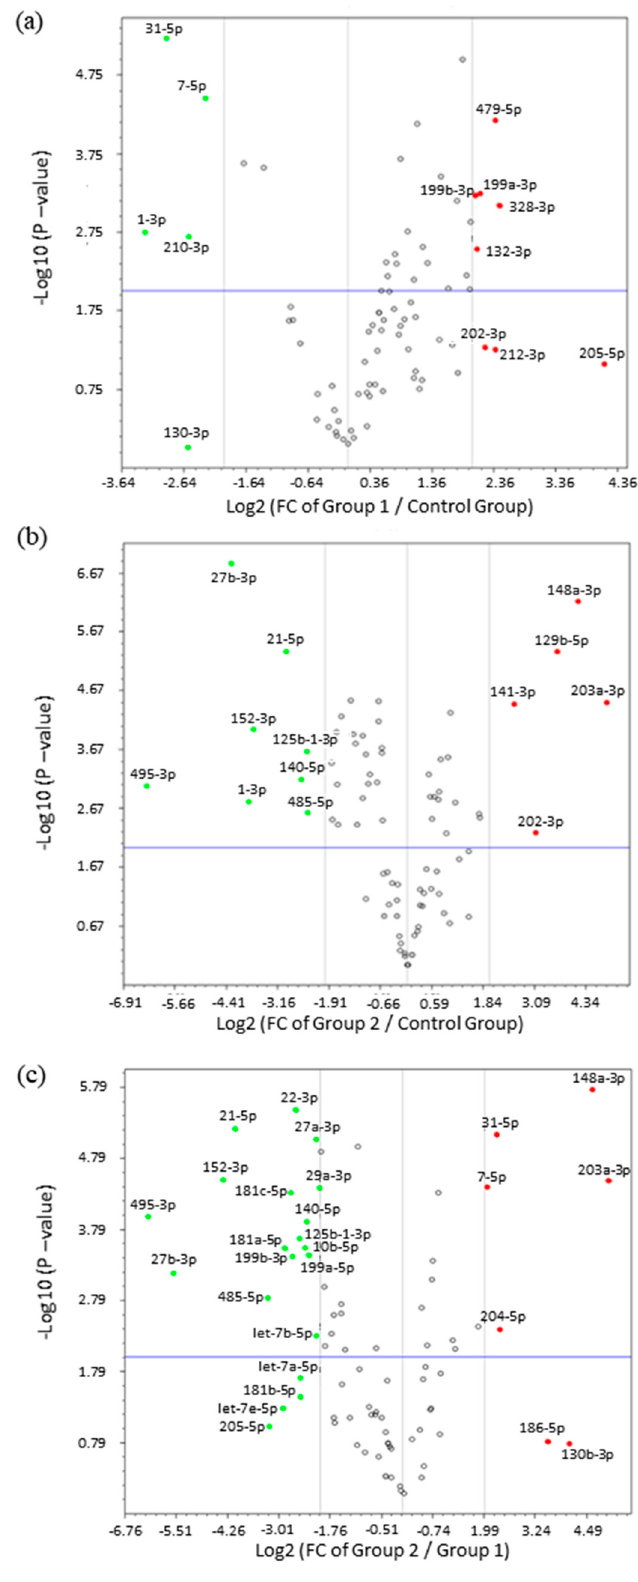
Figure 3. Volcano plots with differentiated expression of miRNAs. ( a ) miRNAs expression in ULM (group 1) compared with MM (control group); ( b ) miRNA expression in ULMS (group 2) compared with MM; ( c ) miRNAs expression in ULMS compared with ULM. FC expression cut-off values of +4 and − 4. In green, down-regulated miRNAs and, in red, up-regulated miRNAs.